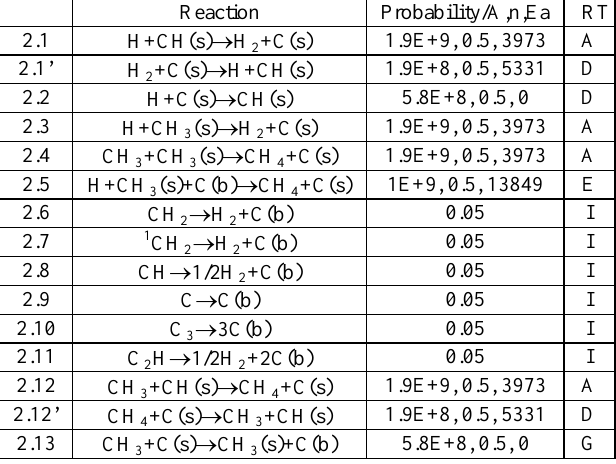
Table 4. Probabilities of the surface reactions on the wafer, model 2, reaction type (RT): A — site activation, D — site deactivation, E — etching, G — growth, I —